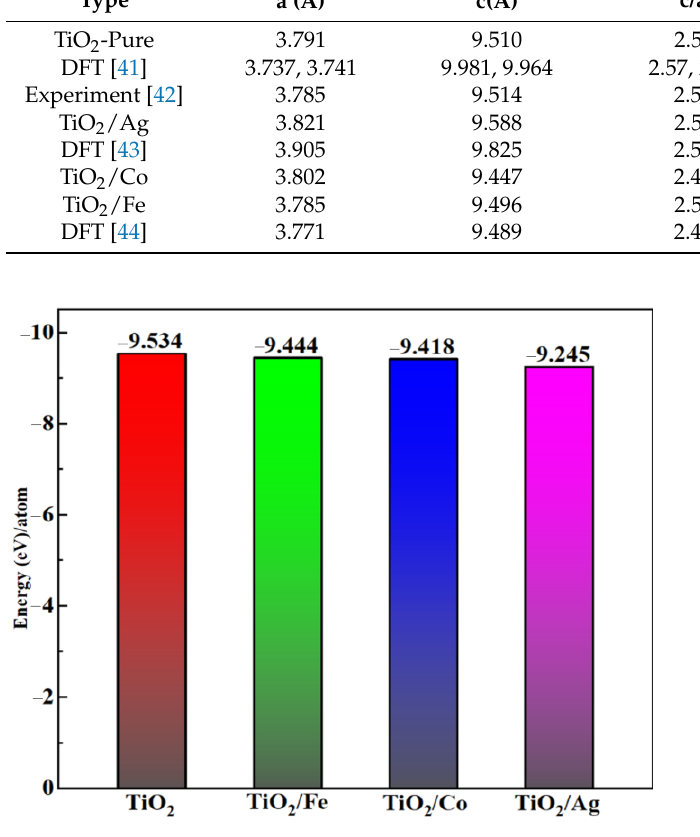
Figure 2. Formation energies per atom of pure and doped TiO 2.